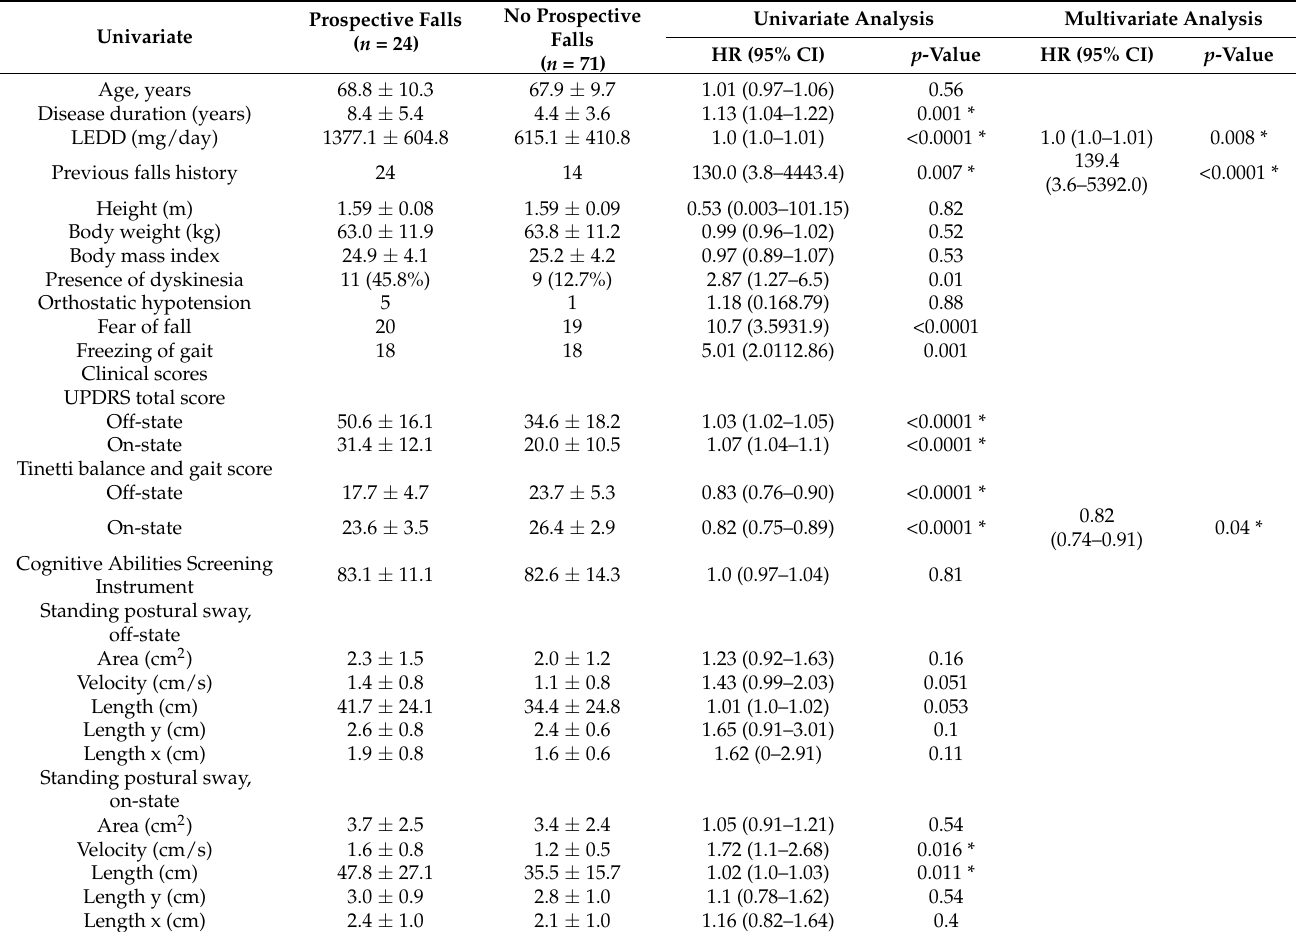
Table 3. Risk factors of clinical scores and posture sway parameters associated with prospective falls in Cox’s proportional hazards